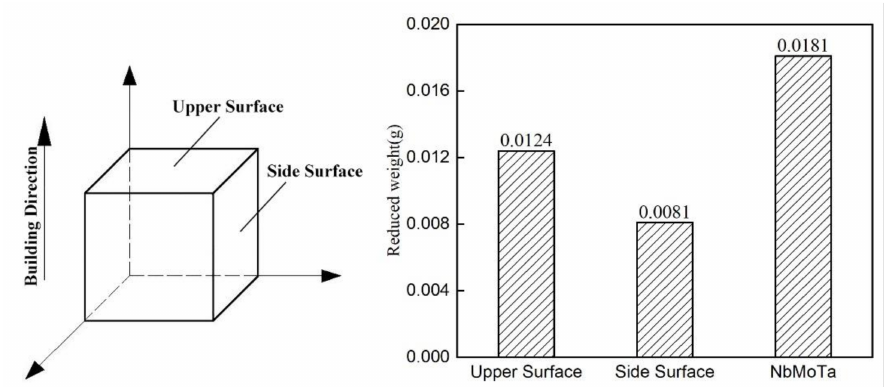
Figure 9. The loss of quality in abrasion resistance